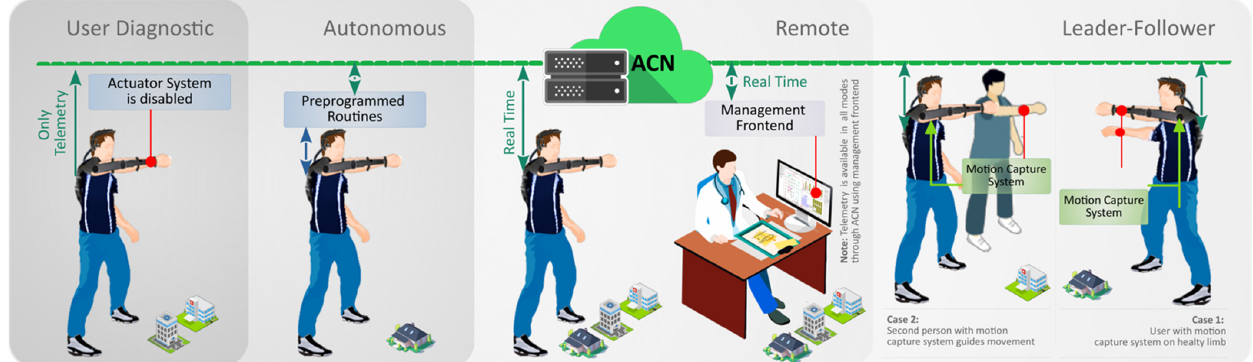
Figure 8. Four operation modes were designed for the exoskeleton